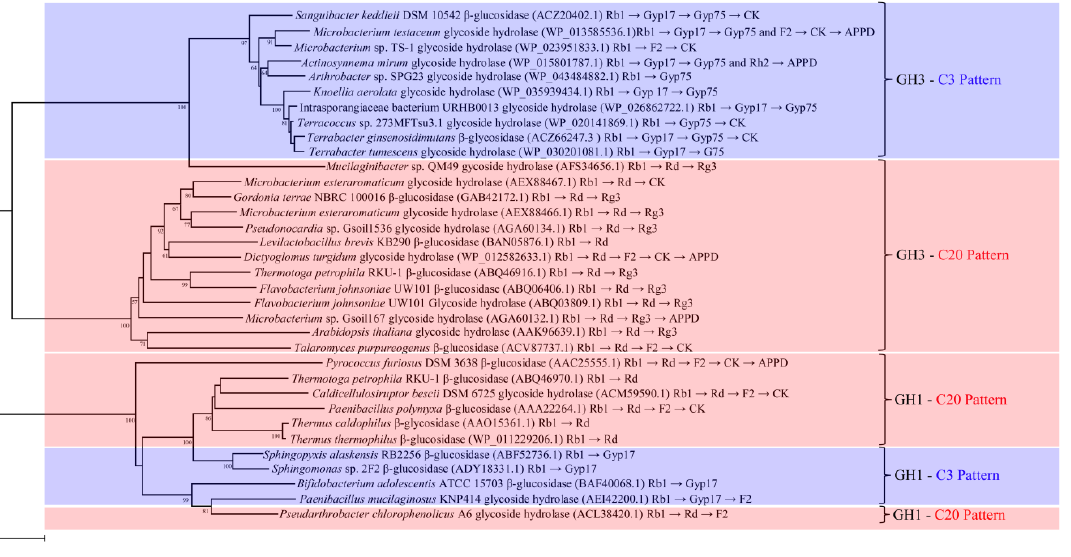
Figure 5. Phylogenetic tree of β -glucosidases with the ability to convert ginsenoside Rb1. The enzyme source, accession number and conversion pathway are given. The tree was built by MEGA using the neighbor-joining method with Poisson model. Bootstrap values ( n = 1000 replicates) are reported as percentages.